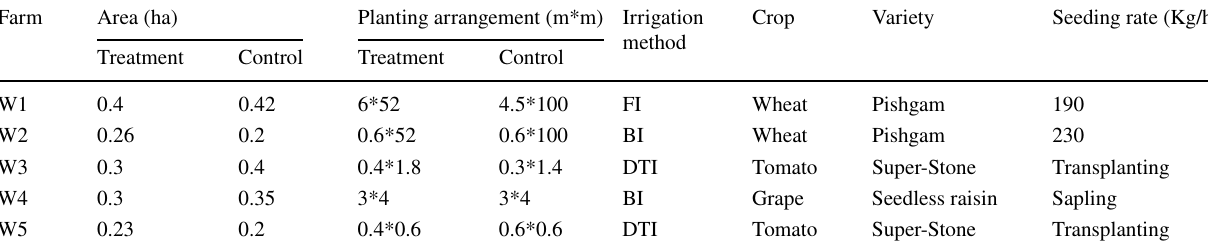
Table 2 Characteristics of selected farms Farm